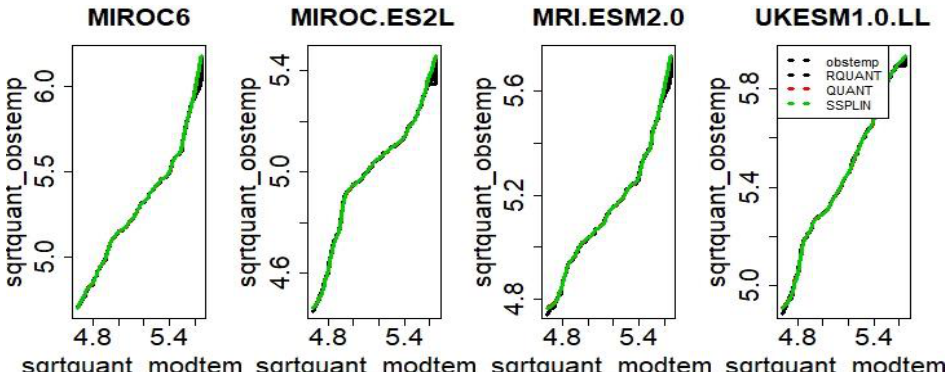
Figure A3. Square root quantile- quantile mapping of model precipitations ( MIROC6 , MIROC-ES2L, MRI-ESM2-0, and UKESM1-0-LL) versus GPCC monthly observation precipitation.